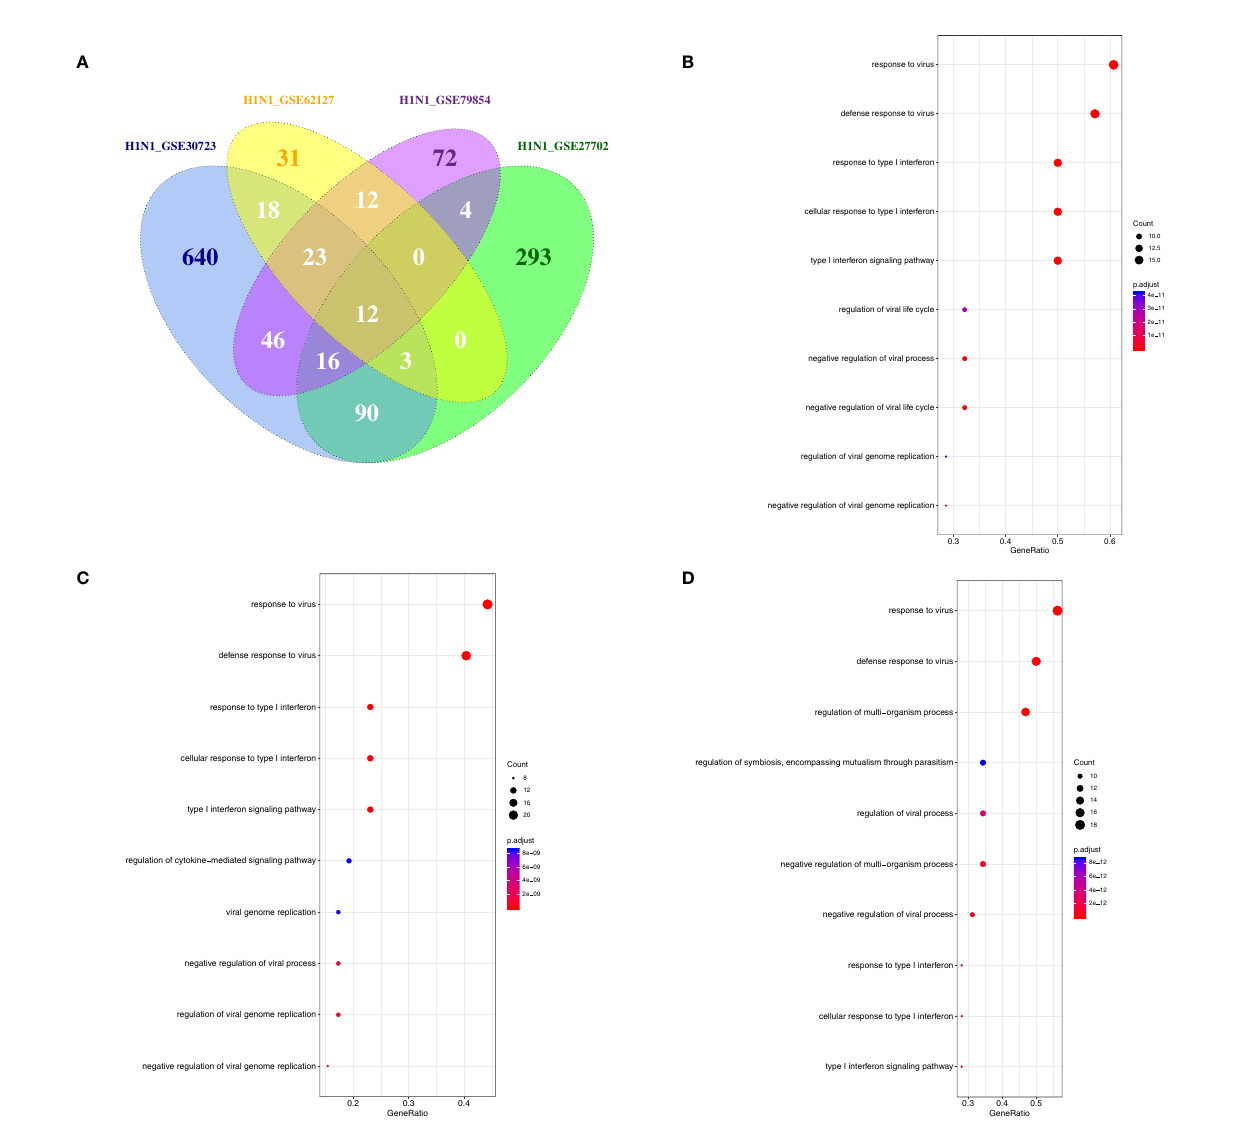
FIGURE 7 | The overlap regulation gene expression of macrophages in response to H1N1 infection. (A) A Venn diagram of the overlap genes in H1N1-infected macrophages, 12 genes were common to the two infected groups. (B) GO biological processes of differentially expressed overlap in H1N1-infected monocytes. The vertical axis shows the functional classi fi cation, and the horizontal axis shows the GeneRatio; (C) GO biological processes of differentially expressed overlap in H1N1- infected monocyte-derived DCs. The vertical axis shows the functional classi fi cation, and the horizontal axis shows the GeneRatio; (D) GO biological processes of differentially expressed overlap in H1N1-infected neutrophils. The vertical axis shows the functional classi fi cation, and the horizontal axis shows the